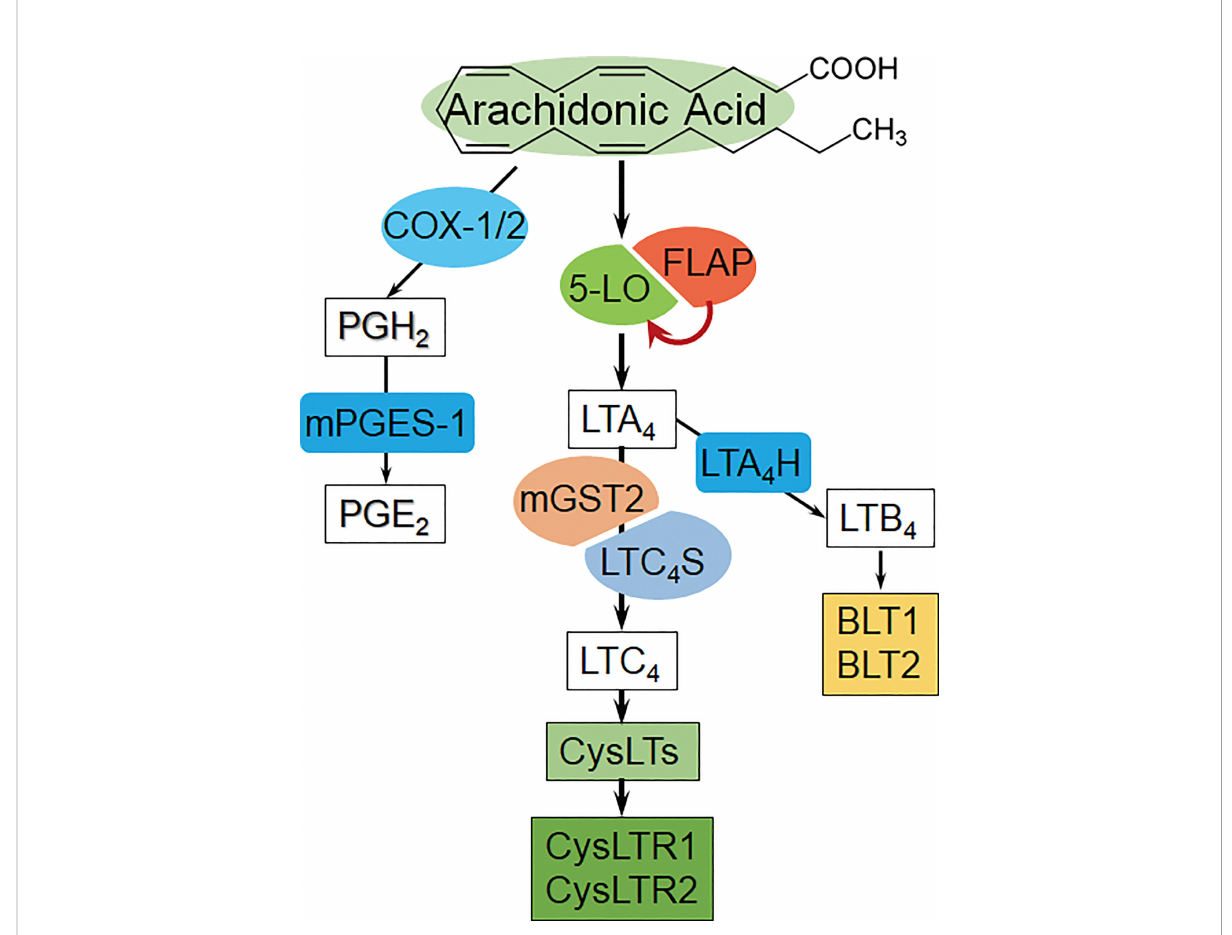
FIGURE 1 The overview diagram of arachidonic acid-derived metabolite pathways. Left: COX/PGE 2 pathway, COX: Cyclooxygenase, mPGES-1: microsomal prostaglandin E synthase-1.. Middle: 5-LO/CysLTs cascade and the receptors [AA is catalyzed by 5-LO/FLAP to form primary metabolite LTA 4 , and then converted to LTC 4 via LTC 4 S (in leukocytes) or mGST2 (in a wide variety of cells); subsequently, LTC 4 exports from cells, and extracellularly cleaves and sequentially forms CysLTs]. Right: LTB 4 bypass, BLT1/2: LTB 4 receptor 1/2. (Summarized from the available